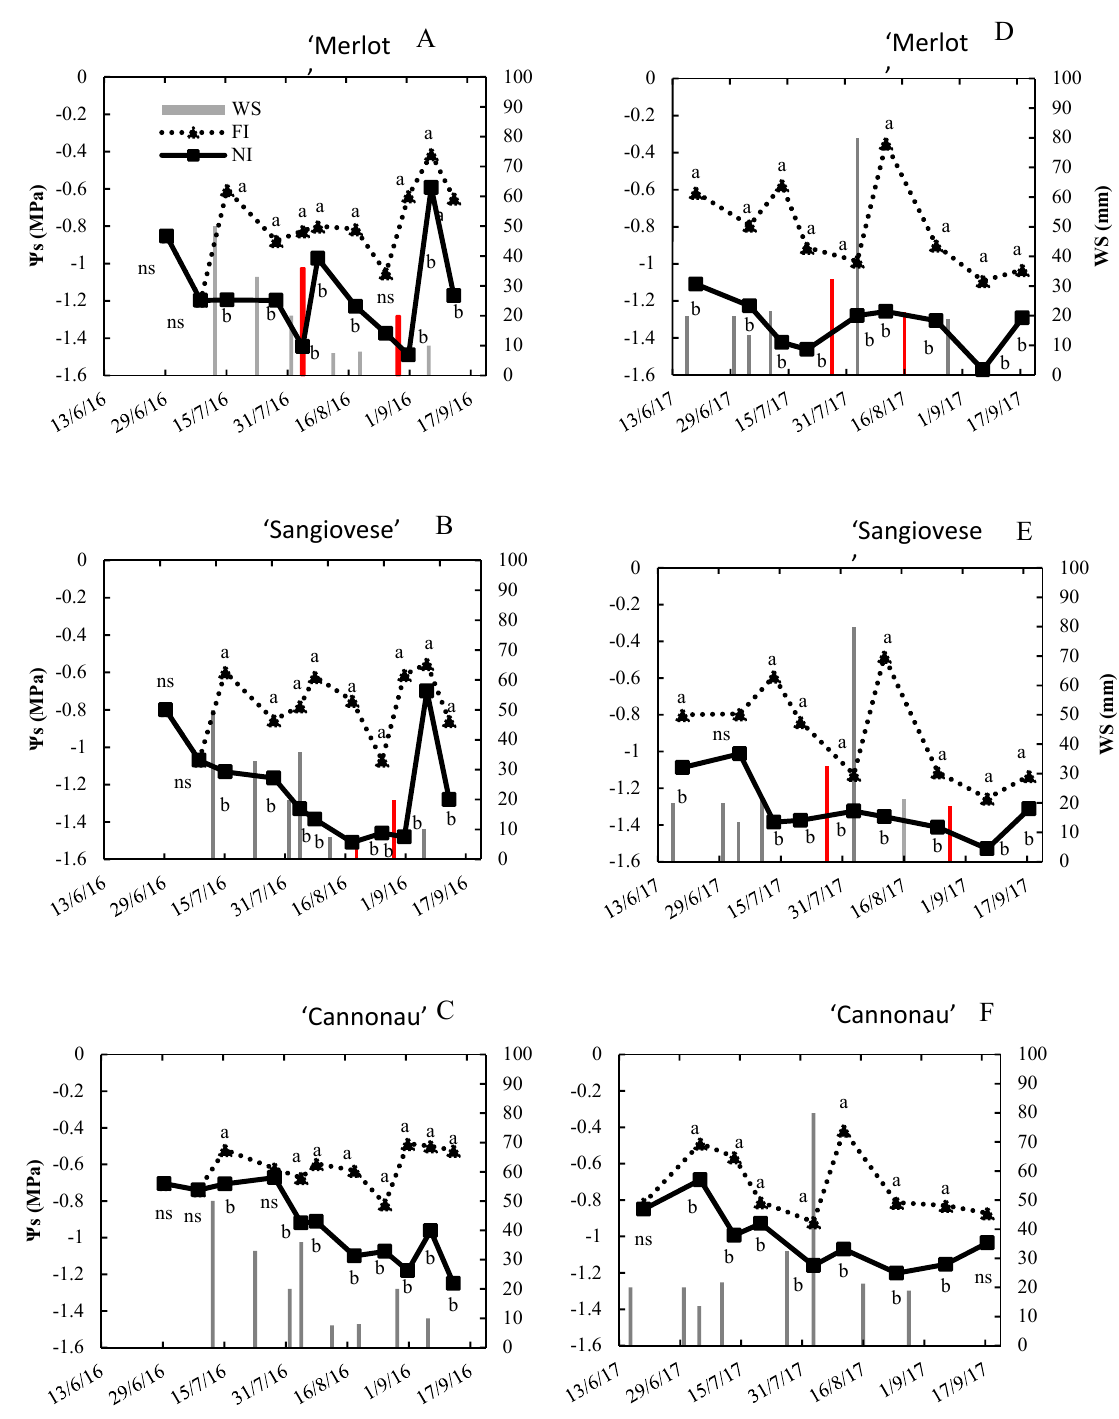
Figure 1. Seasonal patterns in midday stem water potential ( Ψ S) in ‘Merlot’, ‘Sangiovese’ and ‘Cannonau’ vines in 2016 ( A – C ) and 2017 ( D – F ) subjected to full irrigation (FI) and no irrigation (NI) treatments. WS (histogram) = water supply with irrigation treatment. Gray histograms = full irrigation treatment. Red histograms = no irrigation treatment, only irrigated when plant reached − 1.4 MPa stem water potential.